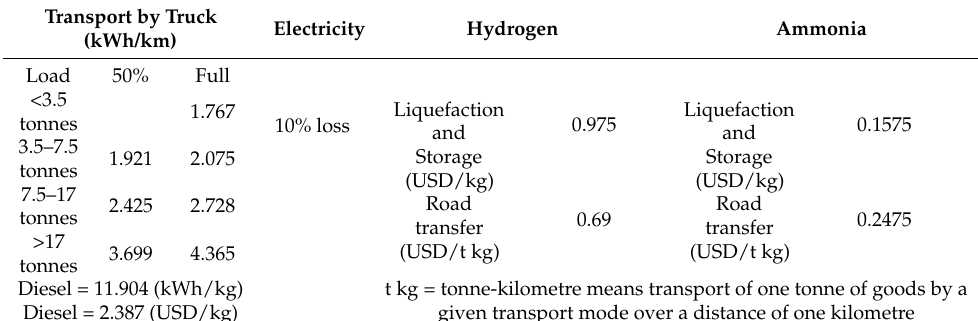
Table 8. Transport cost [67–69].